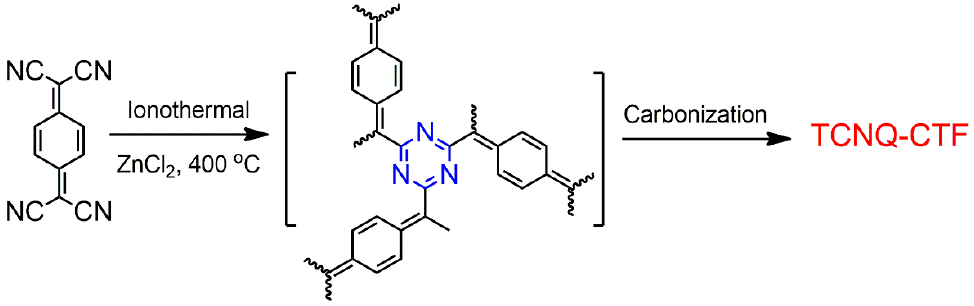
Figure 7. Procedure for the preparation of TCNQ–CTF [58].